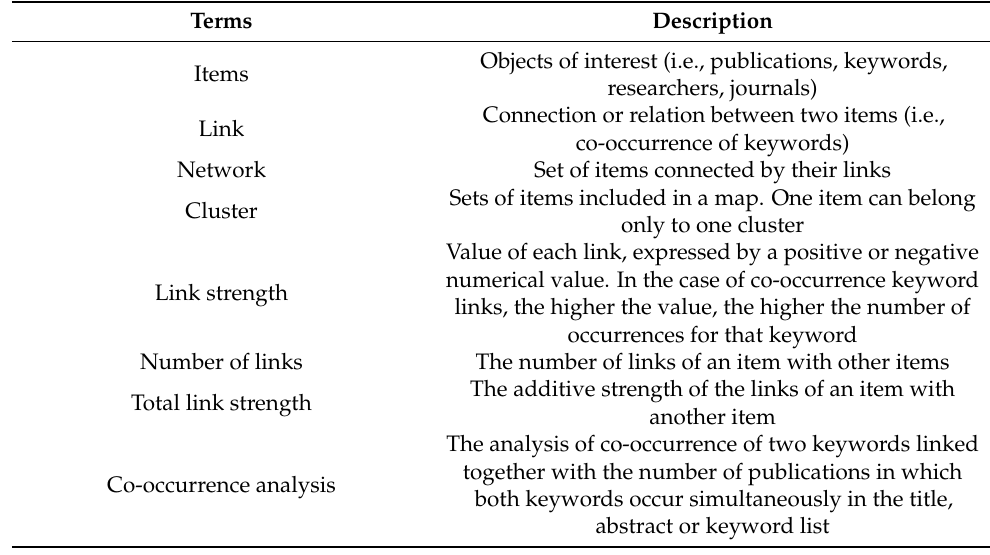
Table 3. Terminology and different types of analysis performed by VOSviewer software [92]. Terms Description Objects of interest (i.e., publications, keywords, Items researchers, journals) Connection or relation between two items (i.e., Link co-occurrence of keywords) Network